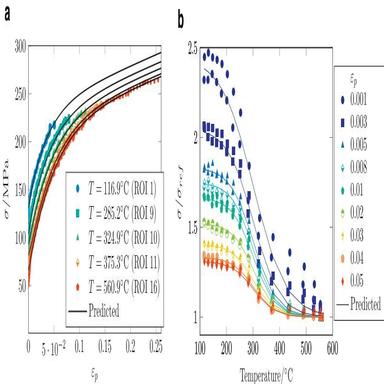
Predicted hardening behaviour with the calibrated model a) comparison with experimental flow curves for 5 different ROIs, b) comparison in terms of normalized stress at different levels of the plastic strain.